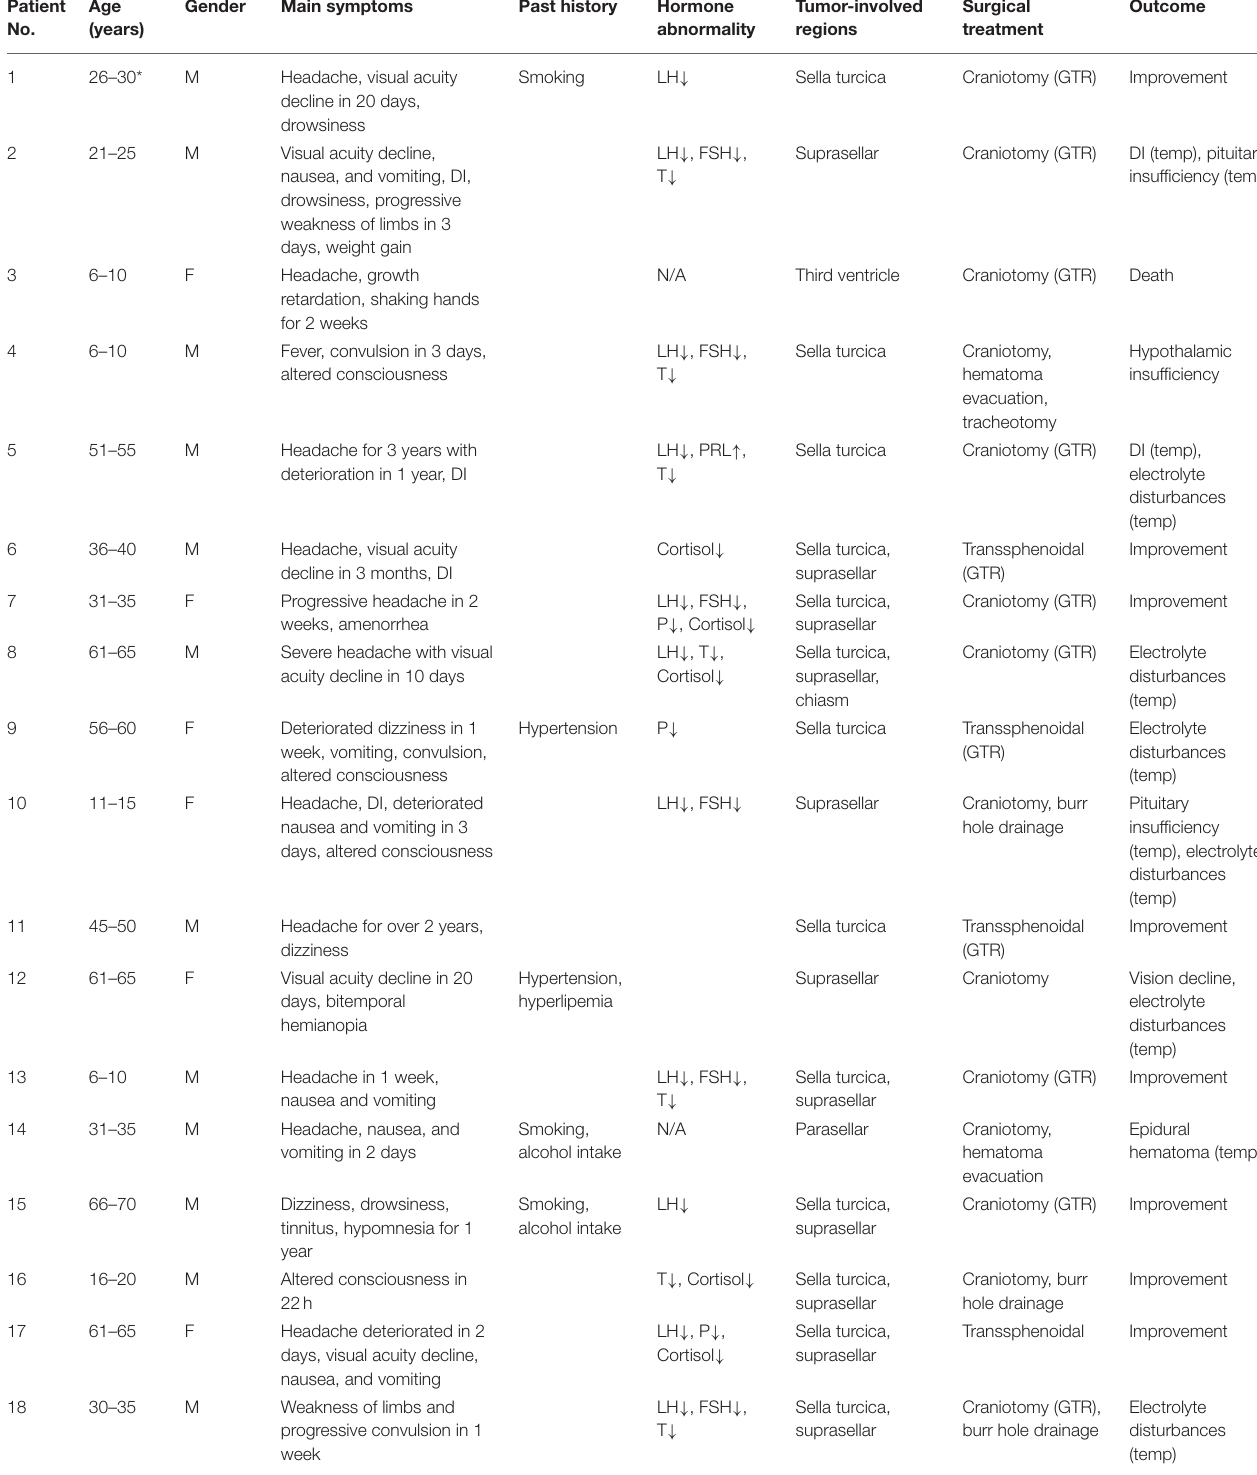
TABLE 3 | Summary of 18 cases of CP with intratumoral hemorrhage. Patient